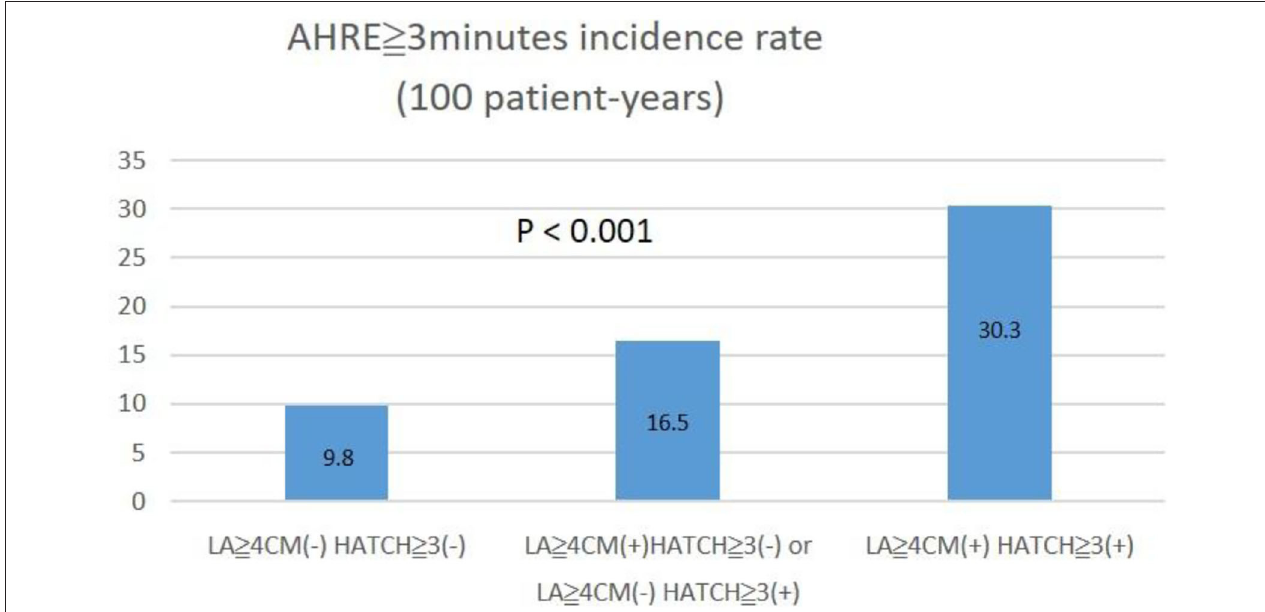
FIGURE 4 | The incidence percentage of AHRE ≥ 3min significantly increased with left atrial size ≥ 4cm and HATCH score ≥